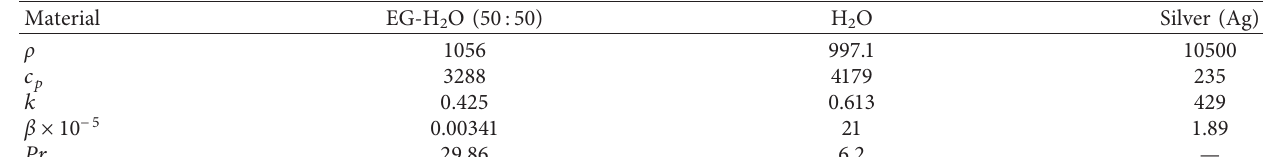
Table 1: Thermo-physical features of nanoparticles and EG